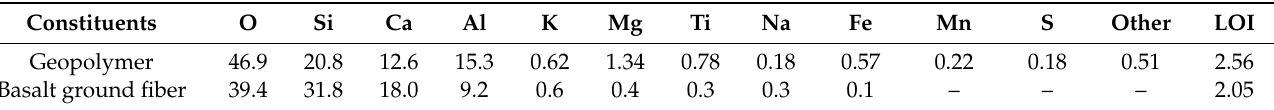
Table 1. Chemical element compositions of raw